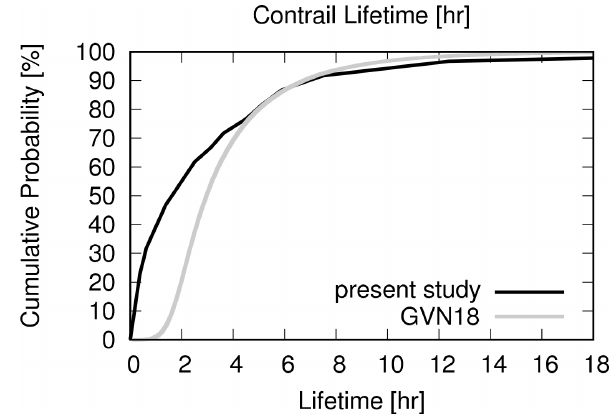
Figure 13. Cumulative probability of contrail lifetimes for all weather situations in comparison to Gierens and Vazquez-Navarro (2018) (i.e.